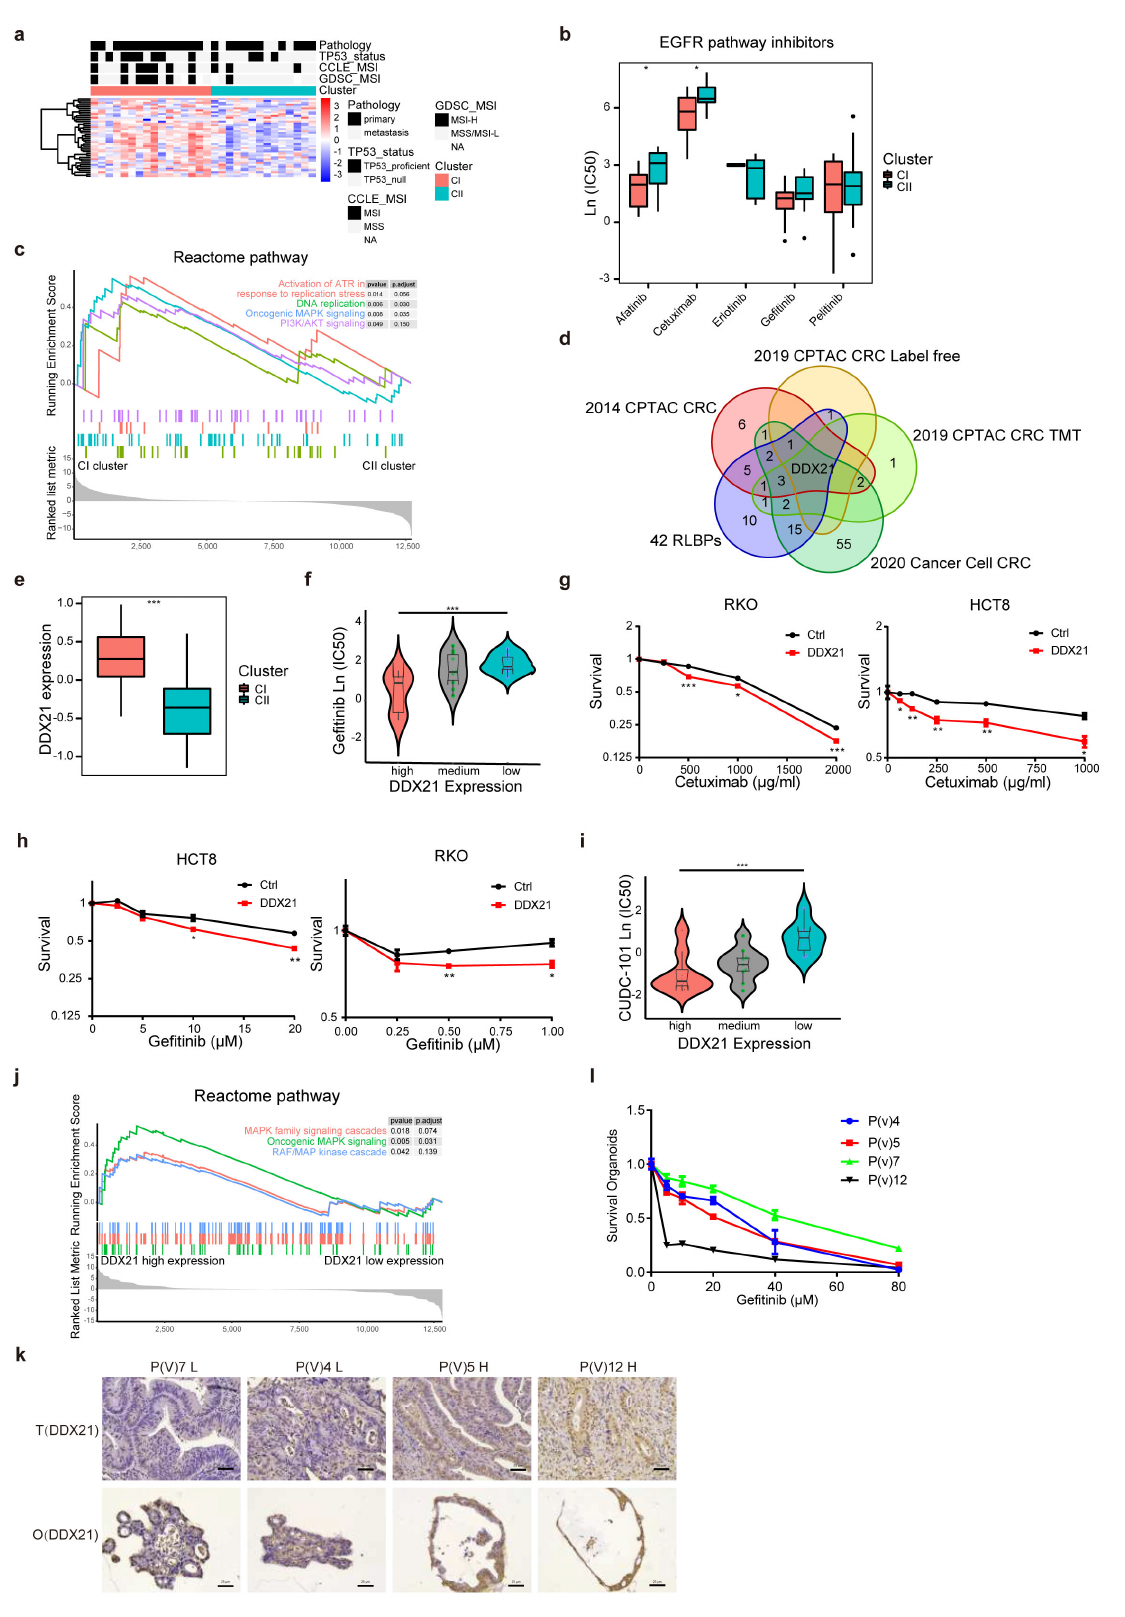
Figure 6. The cell and patient model to verify drug sensitivity. ( a ) Heatmap showing 42 RLBPs expression and clinical features in CRC cells. ( b ) Ln (IC50) of EGFR inhibitors in CRC cells’ sensitivity between two clusters. ( c ) GSEA Reactome enrichment plot showing enrichment pathways in two